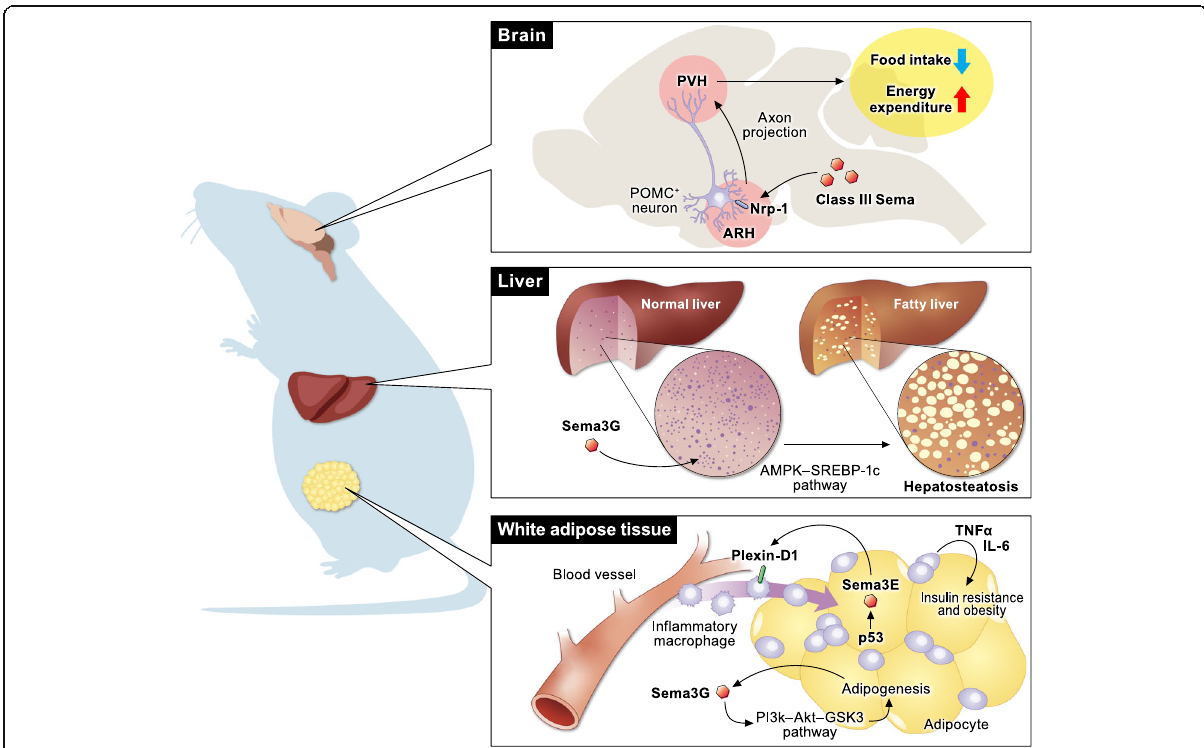
Fig. 1 Multifaceted functions of class III semaphorins in the regulation of systemic metabolism. Sema3E recruits inflammatory macrophages into white adipose tissues via Plexin-D1 and promotes obesity. Sema3G promotes adipogenesis not only in the adipose tissue but also in the liver. In addition to metabolic regulation in the peripheral tissues, class III semaphorins regulate the development of hypothalamic melanocortin circuits, which are essential for systemic energy